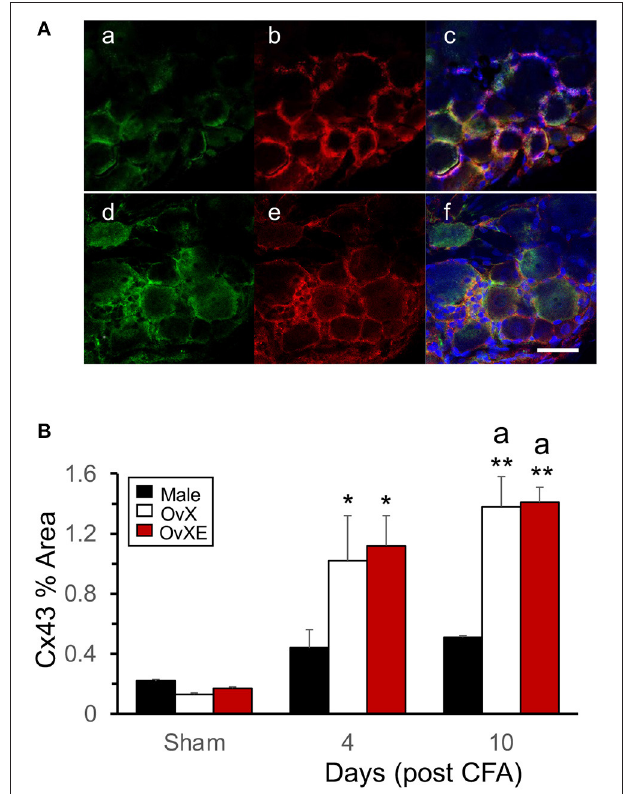
FIGURE 1 | (A) Expression of glial fibrillary acidic protein (GFAP) and connexin43 (Cx43) in the trigeminal ganglion of an OvXE (a–c) and male rat (d–f) 10 days after intra-TMJ injection of CFA. Scale = 30 µ m. (B) Densitometry values expressed as percentage of positive area for Cx43 in male, OvX and OvXE rats under sham conditions and at 4 and 10 days after intra-TMJ injection of CFA based on an average of immunostaining as shown by the examples in panel (A) . * p < 0.05, ** p < 0.01 vs. sham; a p < 0.05 vs. males. Sample size = 4 rats per group, average of 5–7 images per rat.